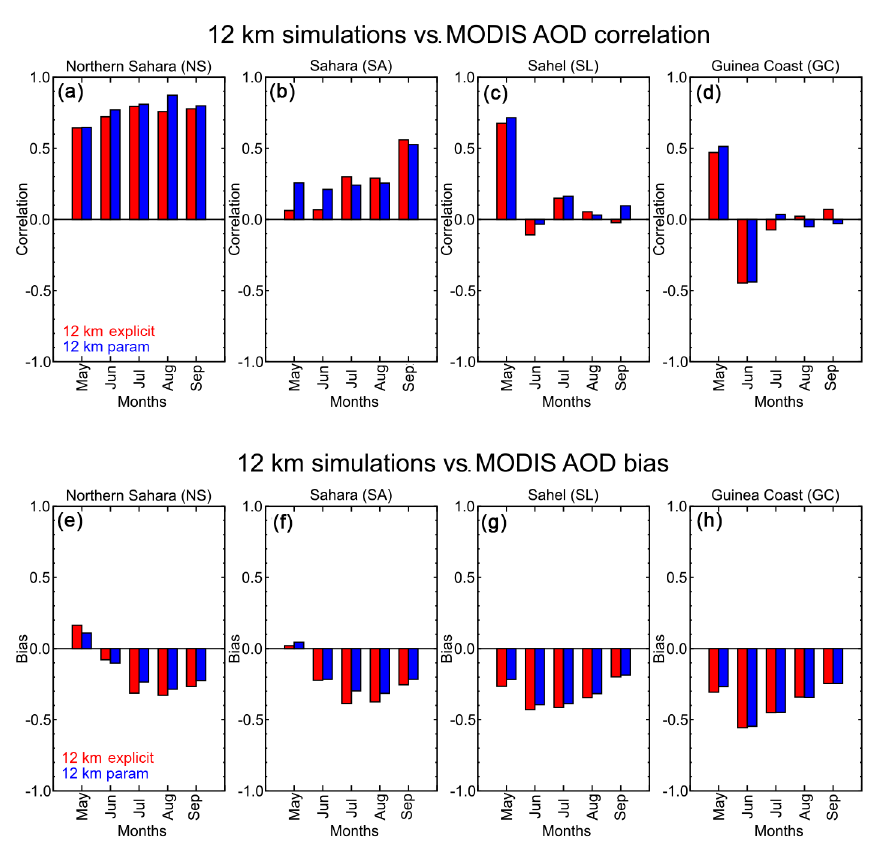
Figure 3. Aerosol optical depth (AOD) correlation coefficients and biases between 12km simulations (explicit and parameterised 10:00UTC) and MODIS AOD retrievals ( ∼ 10:00UTC). (a–d) Monthly mean (May–September) model AOD vs. MODIS AOD correlation coefficients. (e–h) Monthly mean (May–September) model – MODIS AOD biases. Shown are 12km explicit convection simulation (12E, red) and 12km parameterised convection simulation (12P, blue). Correlations and biases calculated from boxes shown and labelled in Fig. 1 ( a–e northern Sahara (NS) box, (b) and (f) Sahara (SA) box, (c) and (g) Sahel (SL) box and (d) and (h) Guinea coast (GC)